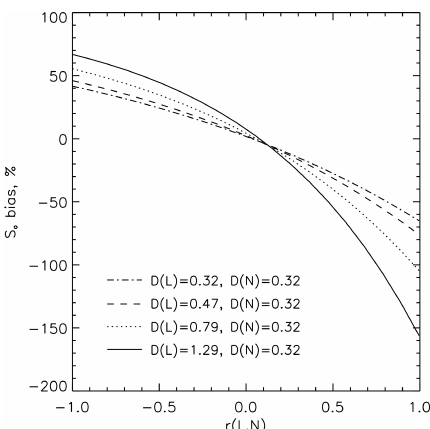
Figure 2. As in Fig. 4 but for the S o bias as a function of the spa- tial correlation between L and N for a range of relative dispersions in L ( D ( L )) and fixed D ( N ). Of note is that for the conditions shown the biases are large and range from about − 150% (posi- tive r , large D ( L )) to + 70% (negative r , large D ( L